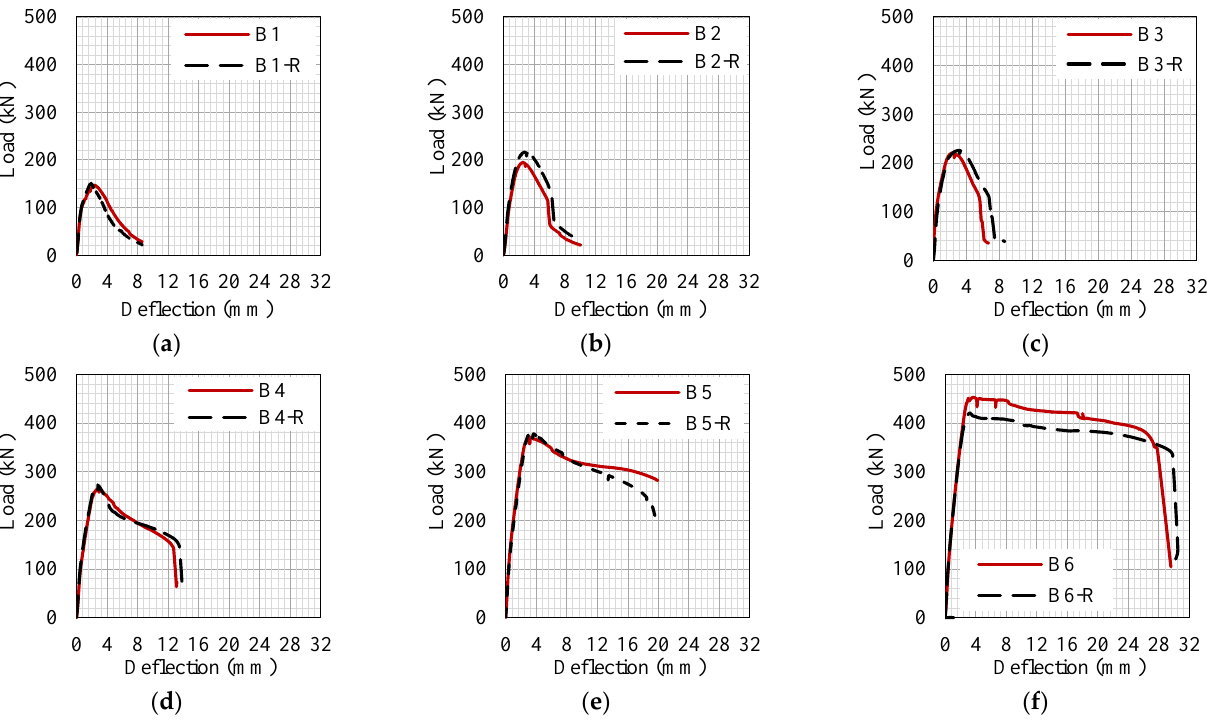
Figure 7. Load – deflection responses of ( a ) B1, ( b ) B2, ( c ) B3, ( d ) B4, ( e ) B5, and ( f ) B6.